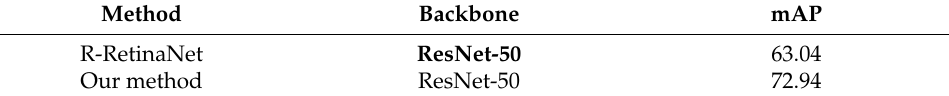
Table 3. Detection accuracy on HRSC2016.